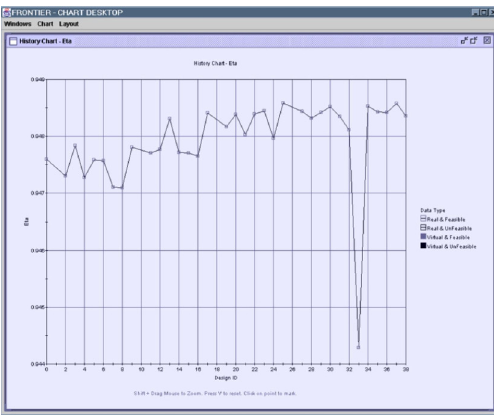
Figure 5: Variables significance in step 2.